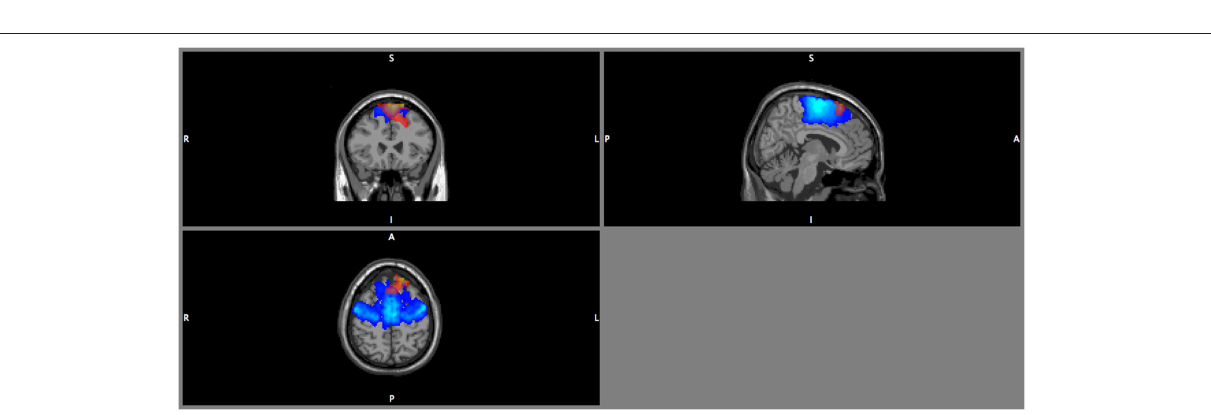
a frequency spectrum reminiscent of movement artifacts (Castermans et al., 2014; Kline et al., 2015) even if that drastically reduced the amount of independent components (although not